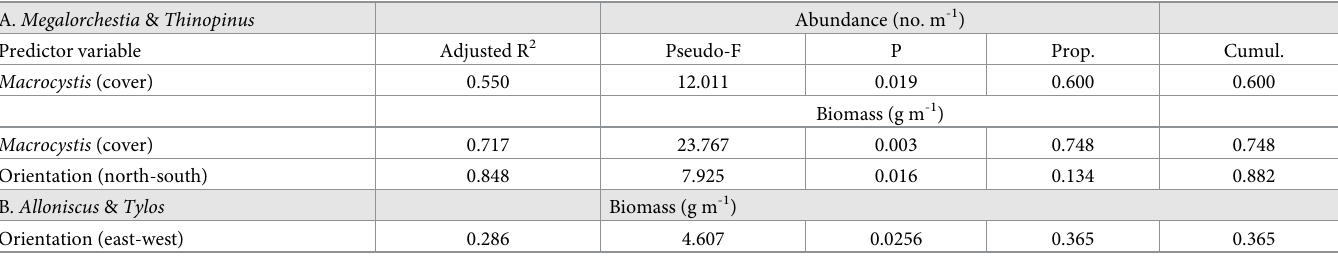
Table 2. Results of DistLM analysis evaluating relationships between the abundance and biomass of endemic beach invertebrates and predictor